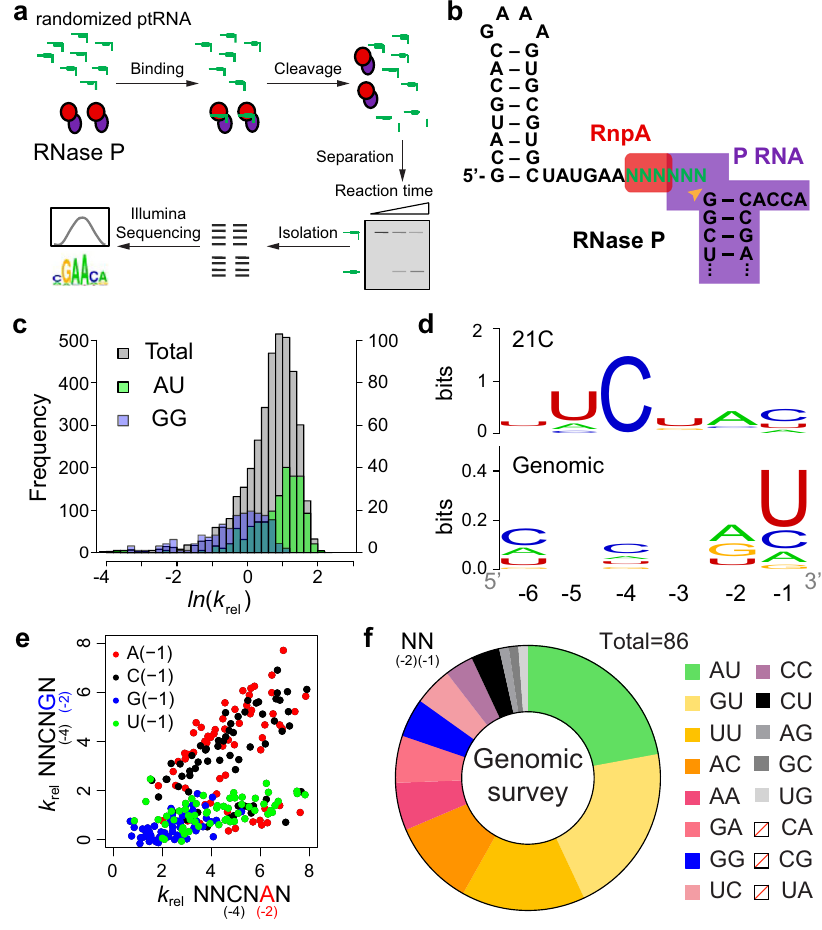
Fig. 2 | HTS-Kin analysis of RNase P 5 ’ leader determinants and anti- determinants due to 3 ’ RCCA pairing. a High-throughput sequencing kinetics (HTS-Kin)involvesgenerationofarandomized poolofsubstrateRNAs,ptRNAsfor RNase P, the residualsubstratepopulation atdifferent timepoints arepuri fi ed and subject to Illumina sequencing. Internal competition kinetics is used to calculate relativerateconstantsforeachsequencefromtheread datayieldingadistribution from which comprehensive speci fi city determinants can be interpreted. b Sequence and 5 ′ leader structure of the ptRNA met (N( − 6) to N( − 1)) randomized pool. The RNase P cleavage site is indicated by an orange arrow, the randomized positions are green. Red and purple boxes indicate the interactions between the substrateand P RNA,rnpA protein,respectively. c Rateconstant distributionshow asaplotofthenumberofsequencesbinnedaccordingtotheir k rel valuescalibrated